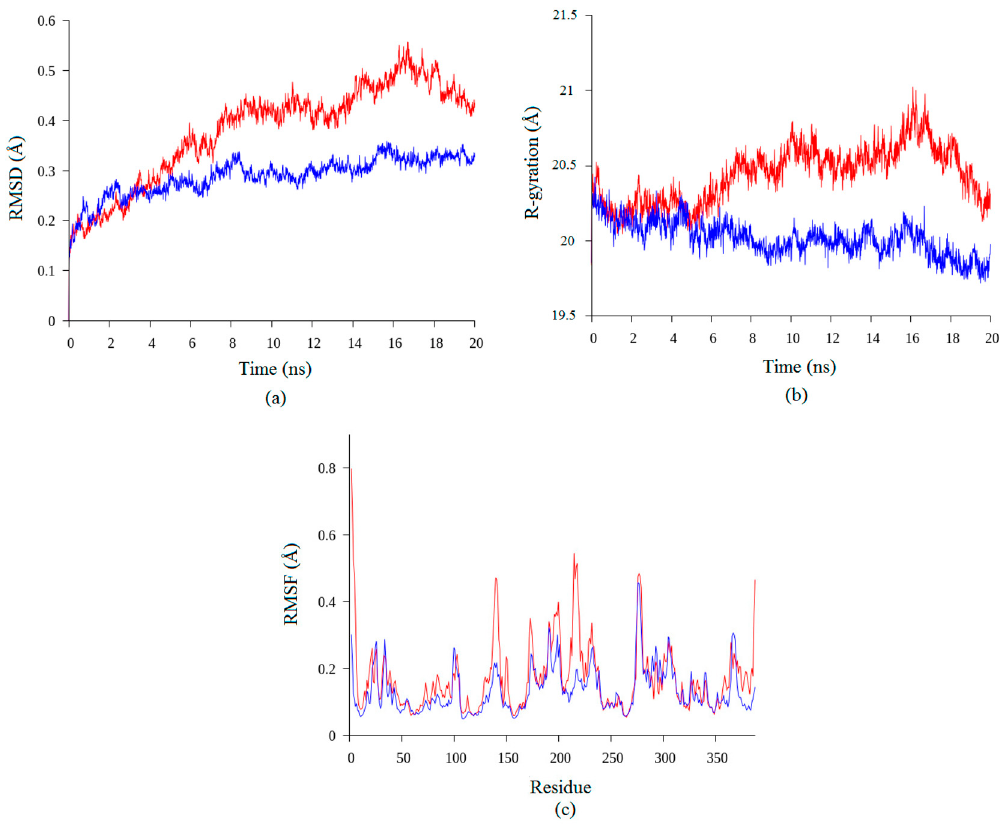
Figure 2. Analysis of molecular dynamic simulation of earth-grown (red) and space-grown (blue) crystal structures in water at 70 ◦ C: ( a ) The Root Mean Square Deviation (RMSD) of earth-grown and space-grown T1 lipase crystal structures; ( b ) Radius of gyration of earth-grown and space-grown T1 lipase crystal structures; ( c ) Root Mean Square Fluctuation (RMSF) of earth-grown and space-grown T1 lipase crystal